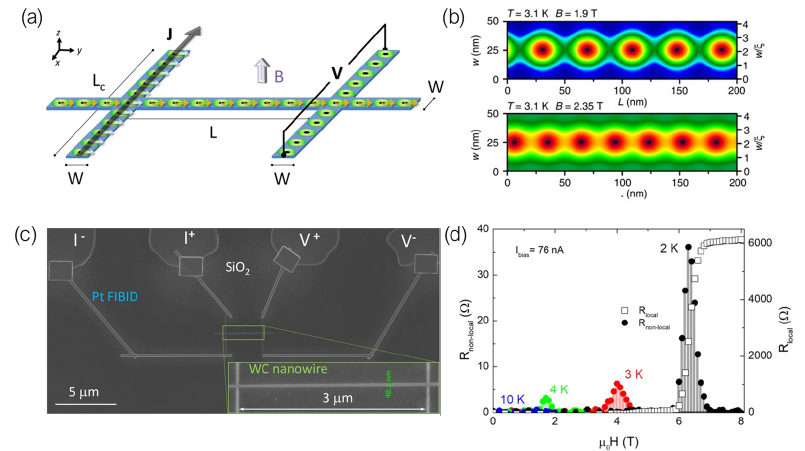
Figure 6. ( a ) Schematic representation of the non-local configuration for vortex transport mea- surements. ( b ) Ginzburg–Landau theory-based numerical simulations of the distribution of the superconducting parameter in a 50 nm-wide nanowire, evidencing the single-row distribution of vortices along the axis. Reprinted from [65], with permissions from Springer Nature. ( c ) SEM image of a superconducting W-C nanowire fabricated by Ga + FIBID, showing the supporting contacts placed for non-local voltage measurements. ( d ) Non-local magneto-resistance curves of the previous nanowire, with the characteristic non-local resistance peaks appearing near the transition at each temperature. Figures ( a , c , d ), reprinted from [121], under CC BY